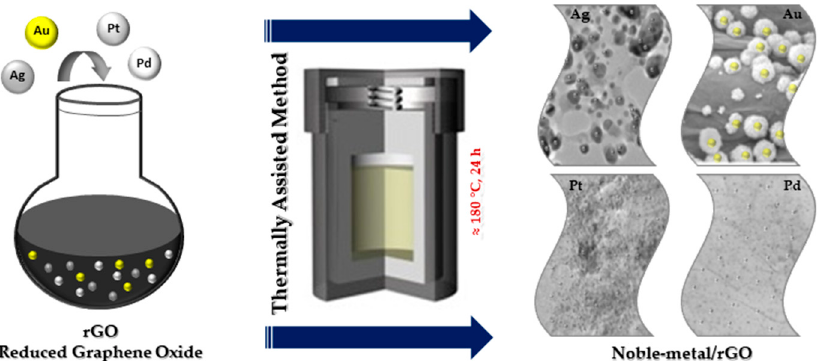
Figure 3. Thermally assisted synthesis of noble metal nanocomposites .